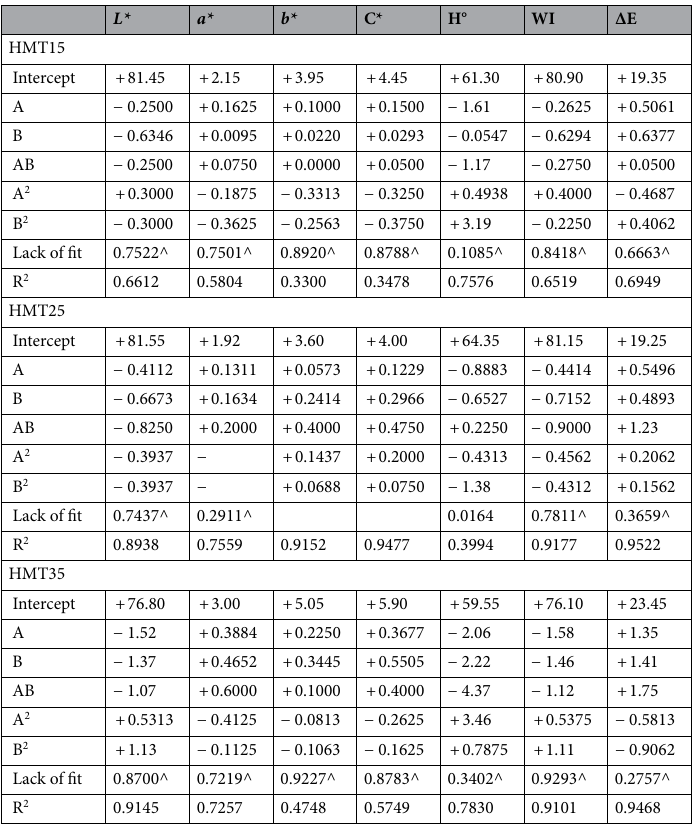
Table 3. Regression models relating colour characteristics and model parameters of heat-moisture treated Bambara groundnut starch. A: linear effect of treatment temperature ; B: linear effect of treatment time ; AB: interaction of temperature and treatment time ; A 2 : quadratic effect of temperature ; B 2 : quadratic effect of treatment time; L*: lightness/darkness; a*: redness/greenness; b*: yellowness/blueness; C*: chroma; H°: hue angle; WI: whiteness index; ∆E: total colour difference. ^ Not significant at p ≥